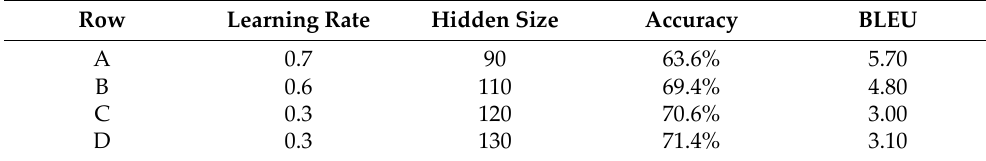
Table 5. Experimental results with different parameters.